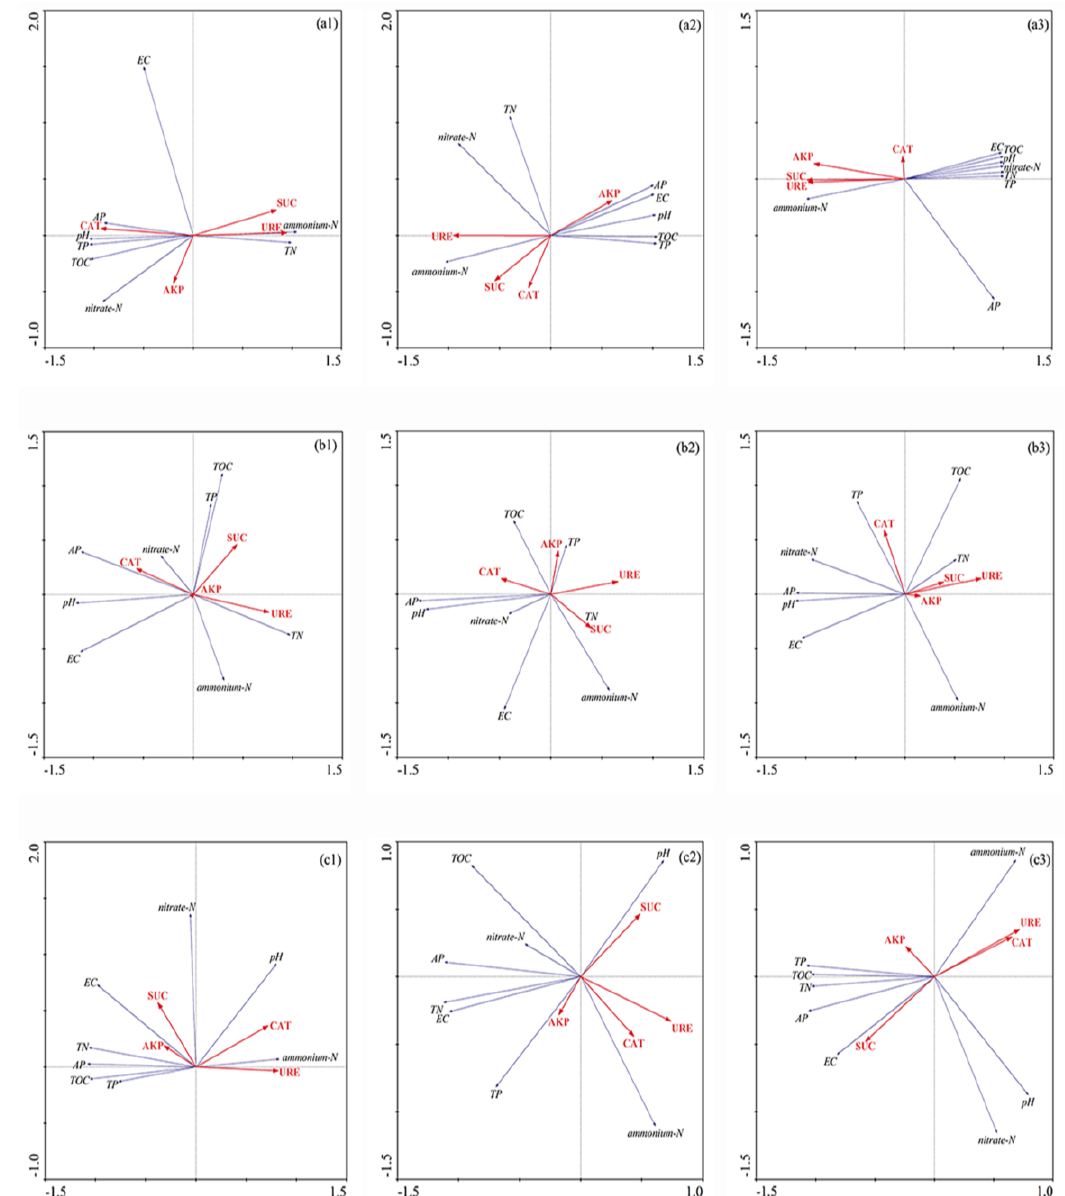
Figure 7. Redundancy analysis of sediment enzyme activities with its biogeochemical properties under the simulation experiment. TOC, total organic carbon; TN, total nitrogen; TP, total phosphorus; AP, available phosphorus; SUC, sucrase; URE, urease; AKP, alkaline phosphatase; CAT, catalase; pH, potential of hydrogen; EC, electrical conductivity; ammonium-N, ammonium nitrogen; nitrate-N, nitrate nitrogen; ( a1 ) control treatment of GIW in permanent flooding period; ( a2 ) 2.5 °C warmed treatment of GIW in a permanent flooding period; ( a3 ) 5.0 °C warmed treatment of GIW in a permanent flooding period; ( b1 ) control treatment of GIW in an inter-annual flooding period; ( b2 ) 2.5 °C warmed treatment of GIW in an inter-annual flooding period; ( b3 ) 5.0 °C warmed treatment of GIW in an inter-annual flooding period; ( c1 ) control treatment of GIW in a seasonal flooding period; ( c2 ) 2.5 °C warmed treatment of GIW in a seasonal flooding period; ( c3 ) 5.0 °C warmed treatment of GIW in a seasonal flooding period.